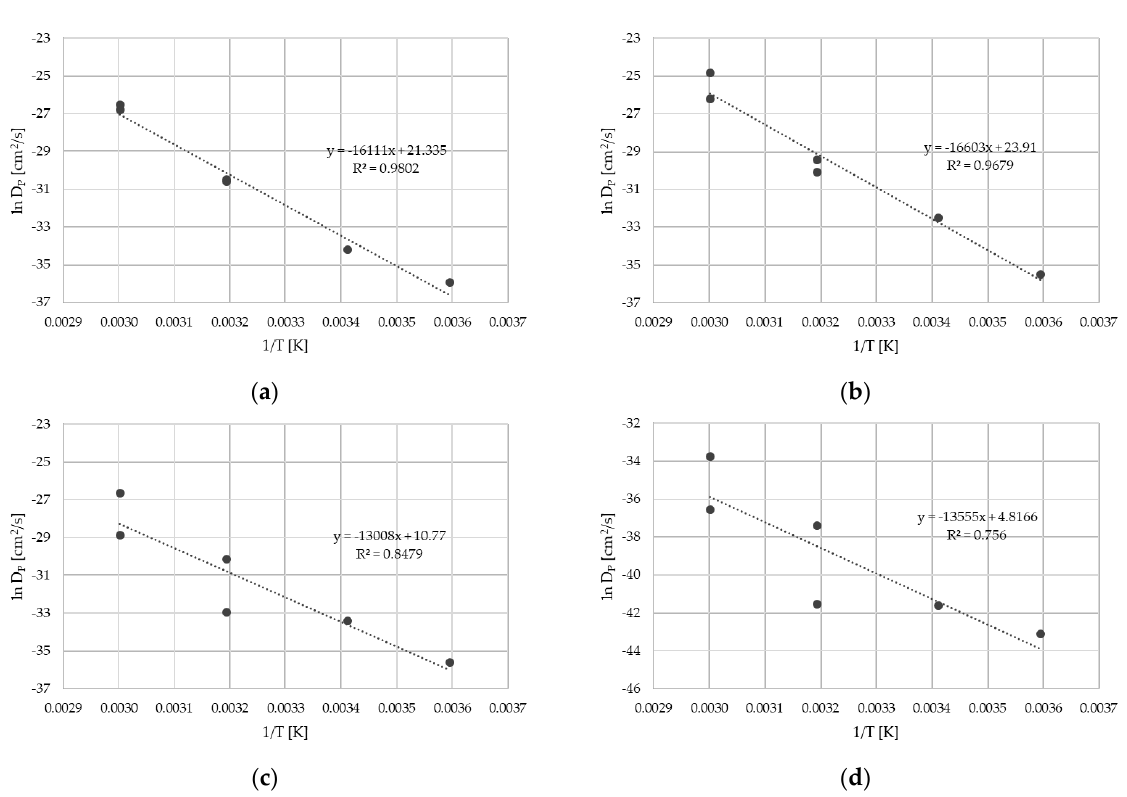
Figure 3. Arrhenius plots for toluene ( a ), chlorobenzene ( b ), styrene ( c ), and phenyl cyclohexane ( d ). Diffusion coefficients D P from Table 4.